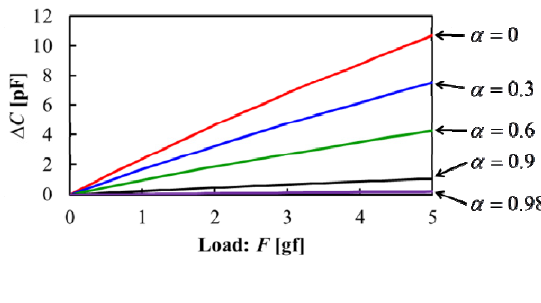
Figure 3. Load vs. change in capacitance dependent on initial position ( α